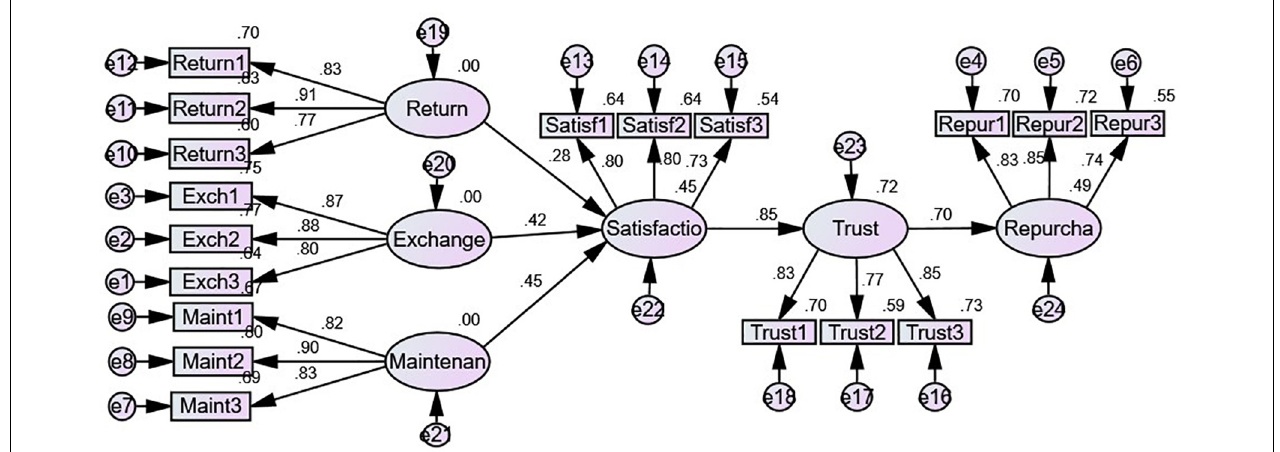
FIGURE 3 | Results for female (gender code = 2)